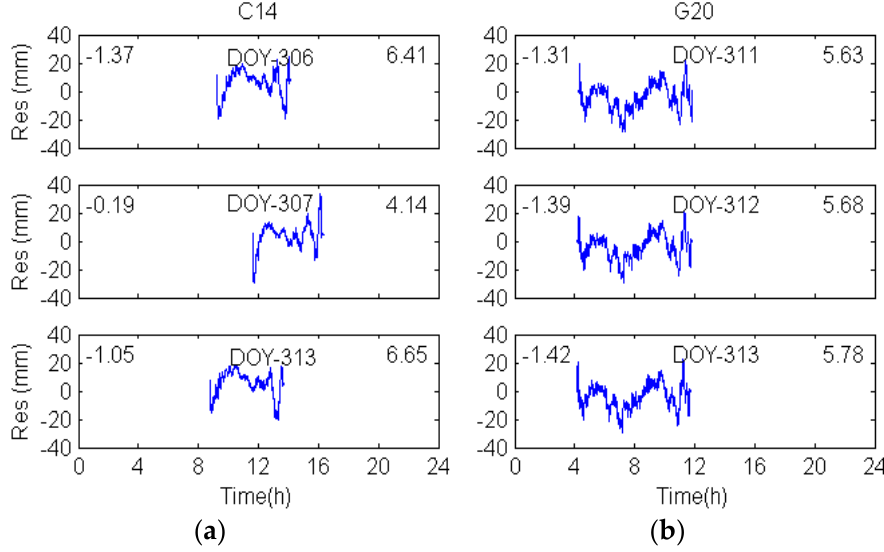
Figure 6. Denoised DD residuals for MEO-C14 ( a ) and GPS-G20 ( b ).